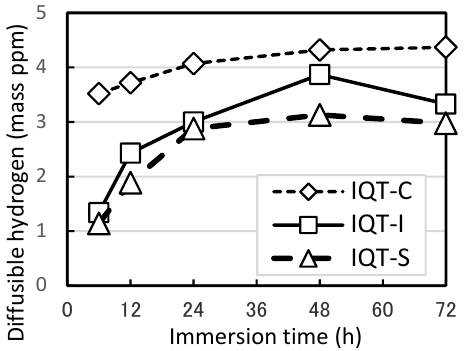
Figure 16. Relationship between immersion time and di ff usible hydrogen content in 323 K-20 % NH 4 SCN